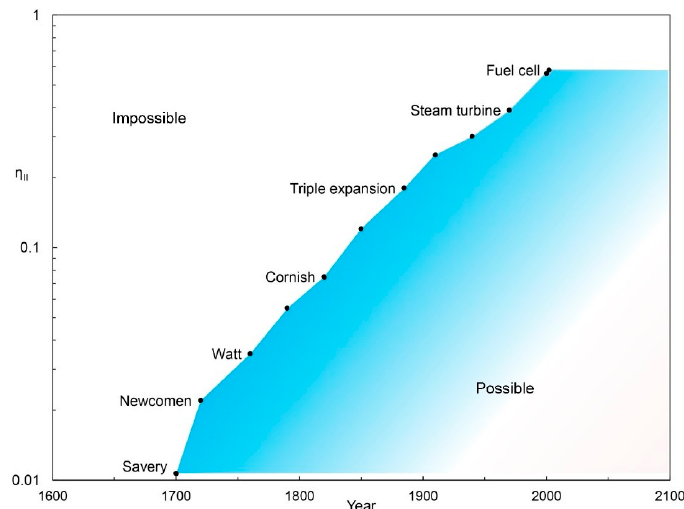
Figure 4. The evolution of the design space of power plants, which is bordered from above by the second-law efficiencies of the new models that were adopted [3].